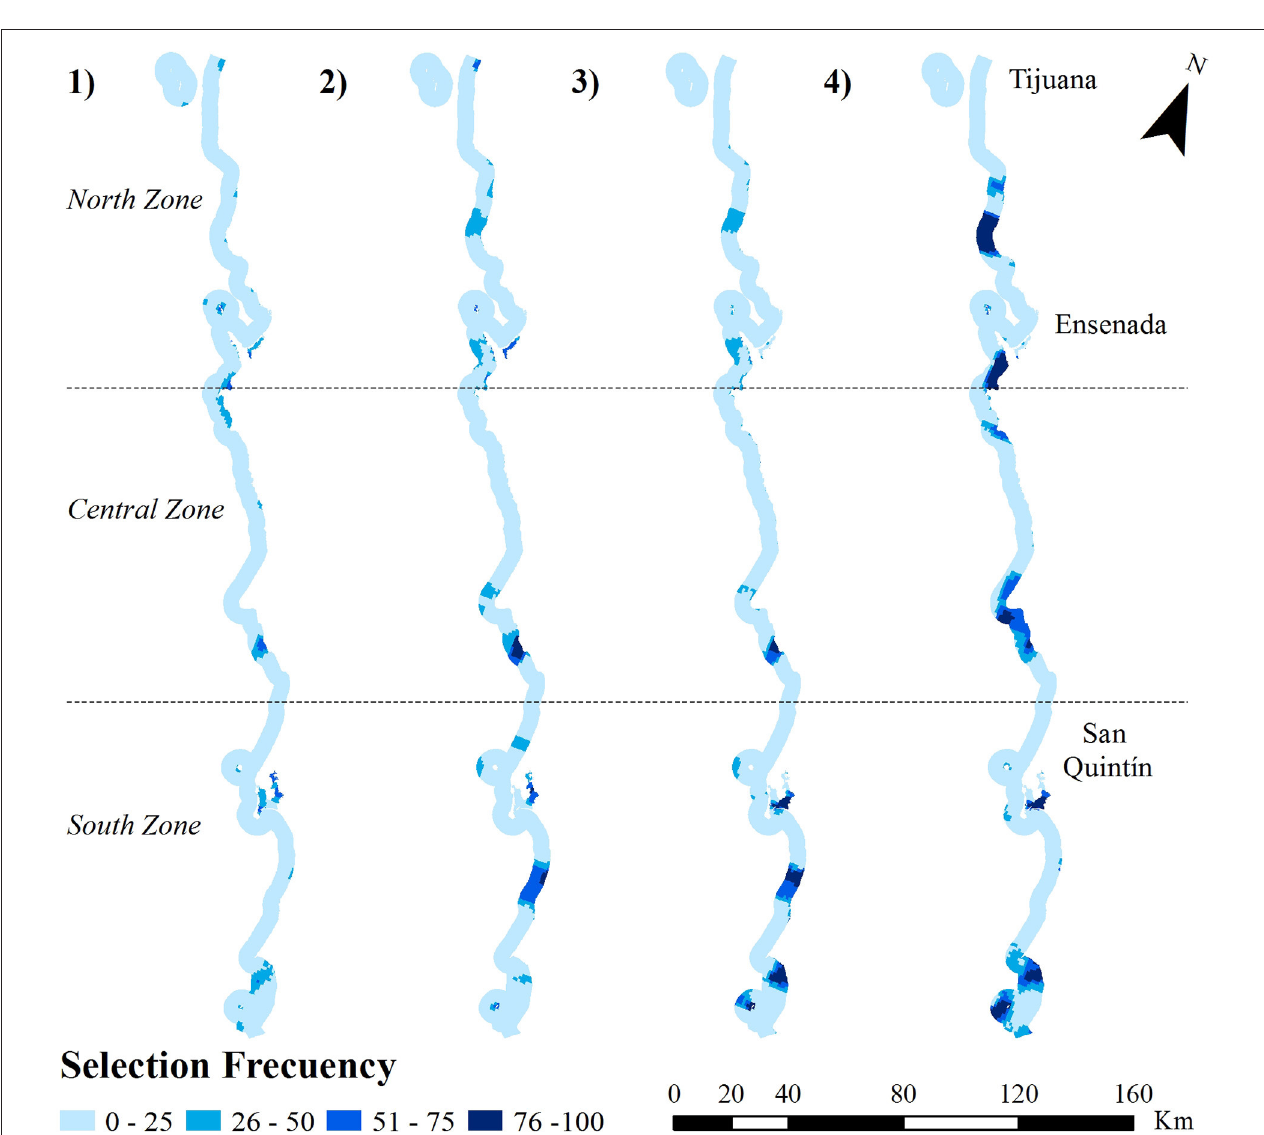
FIGURE 5 | Selection frequency (percentage that a planning unit is selected from 100 runs with Marxan) of the four scenarios: (1) Representation, (2) Cost, (3) Condition, (4) Enforcement.